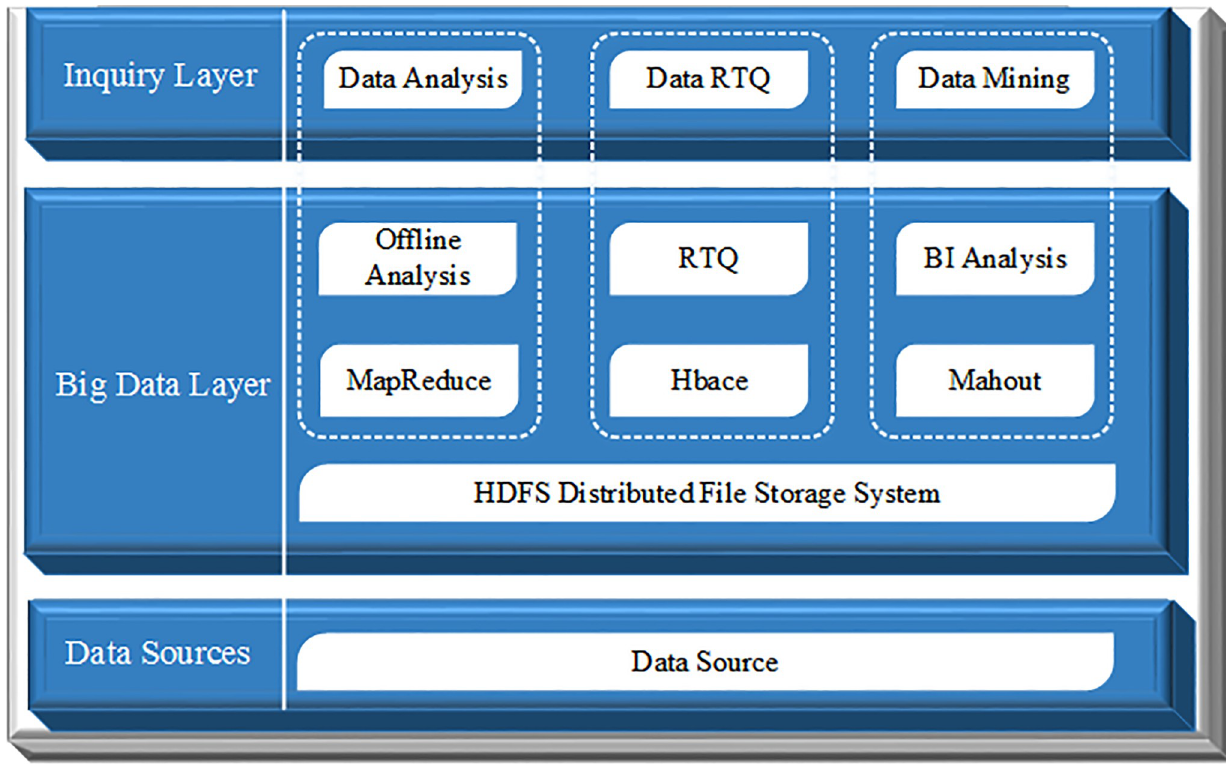
Fig 2. Overall framework of Hadoop